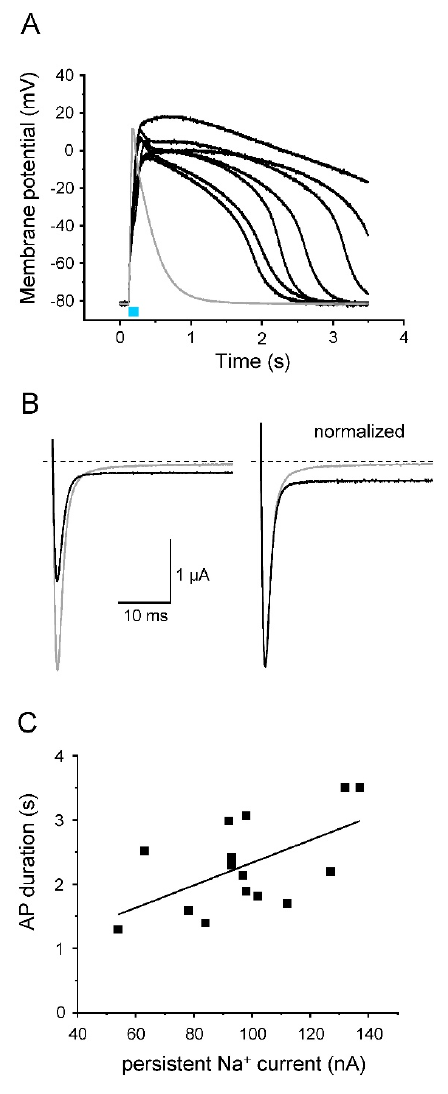
Figure 9. Prolongation of AP repolarization by LQT3 deletion variant ∆ KPQ. ( A ) Representative light-induced APs from 7 different oocytes expressing Na v 1.5-CC- ∆ KPQ. The 30 ms-light pulse is illustrated as a blue bar. The gray line represents an AP from a control oocyte injected with Na v 1.5-CC-2. For detailed statistics, see Table 3 and “Supplementary Materials” (Table S1). ( B ) Corresponding whole-cell Na + currents elicited by a test pulse to − 20 mV (holding potential − 120 mV; gray line: Na v 1.5-CC-2; black line: Na v 1.5-CC- ∆ KPQ; right: current traces normalized to the peak current). In Na v 1.5-CC- ∆ KPQ, the non-inactivating current fraction was significantly increased (up to 7% of the transient current). At the same time, we noticed a reduced peak current compared to Na v 1.5- CC-2. ( C ) Correlation between AP duration, measured in the current-clamp mode at − 40 mV, and the corresponding persistent current at − 20 mV, recorded in the voltage-clamp mode ( n = 15 from 6 different batches of oocytes). The line represents the results of a linear fit (y = 0.02x; R 2 =